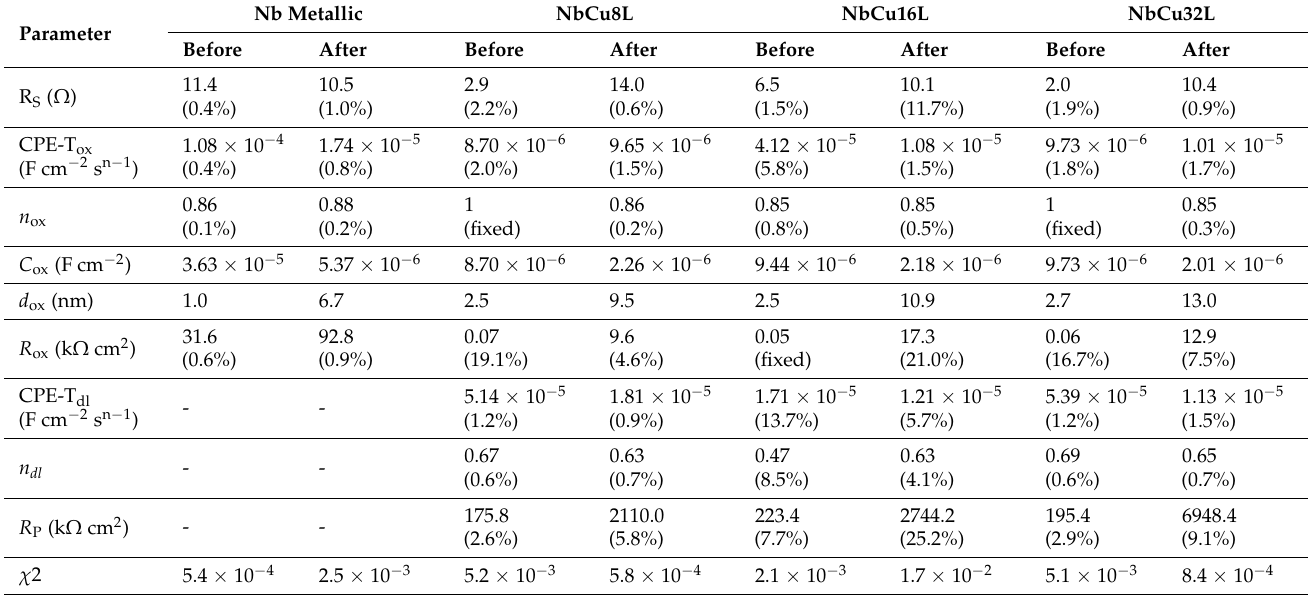
Table 4. EEC parameters obtained by fitting EIS data of metallic Nb and Nb-coatings in O 2